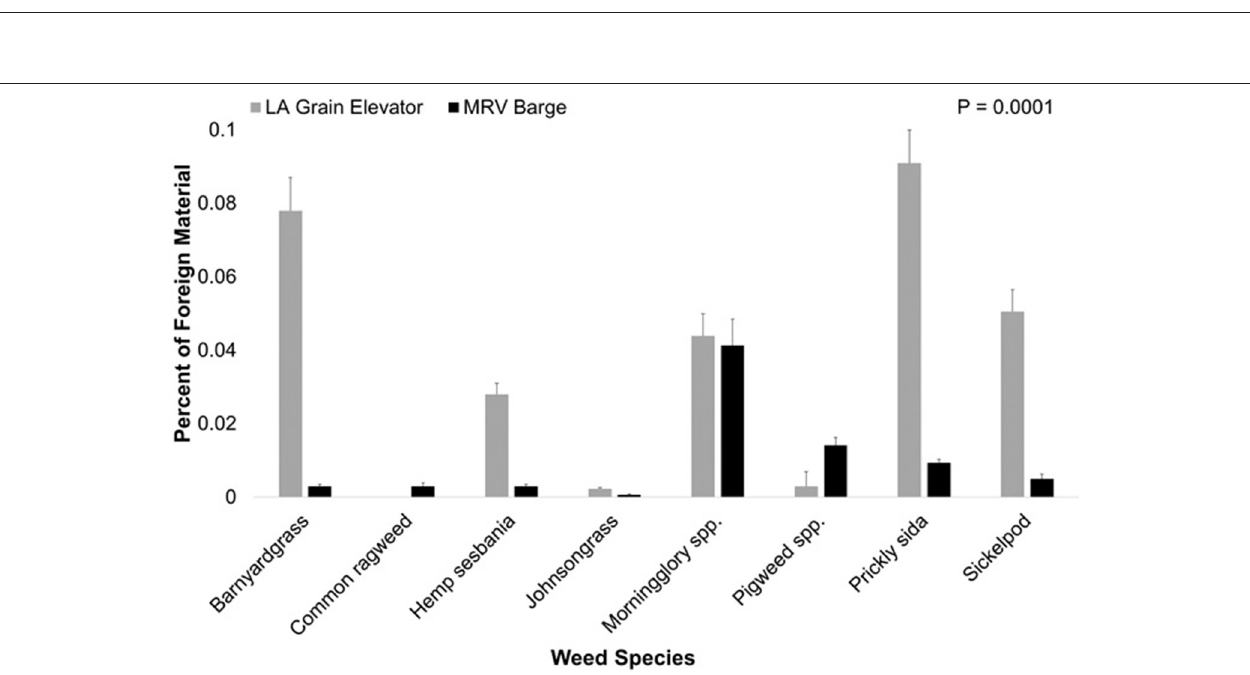
FIGURE 3 | Occurrence of weed seed in grain samples, at local Louisiana grain elevators and at various Mississippi River (MRV) barges, expressed as a percentage of the weight of foreign material.